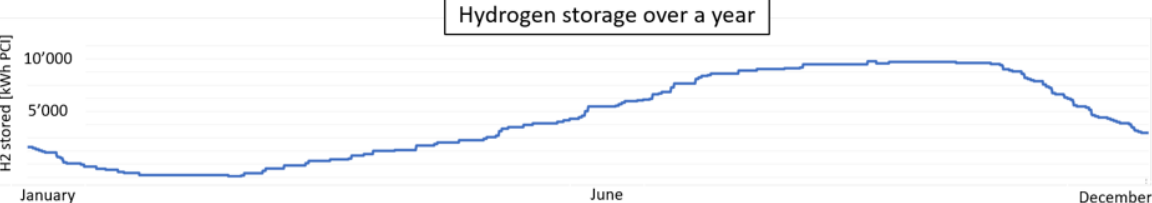
Figure 5. Amount of H stored over a one-year period time using the peaks limitation 2